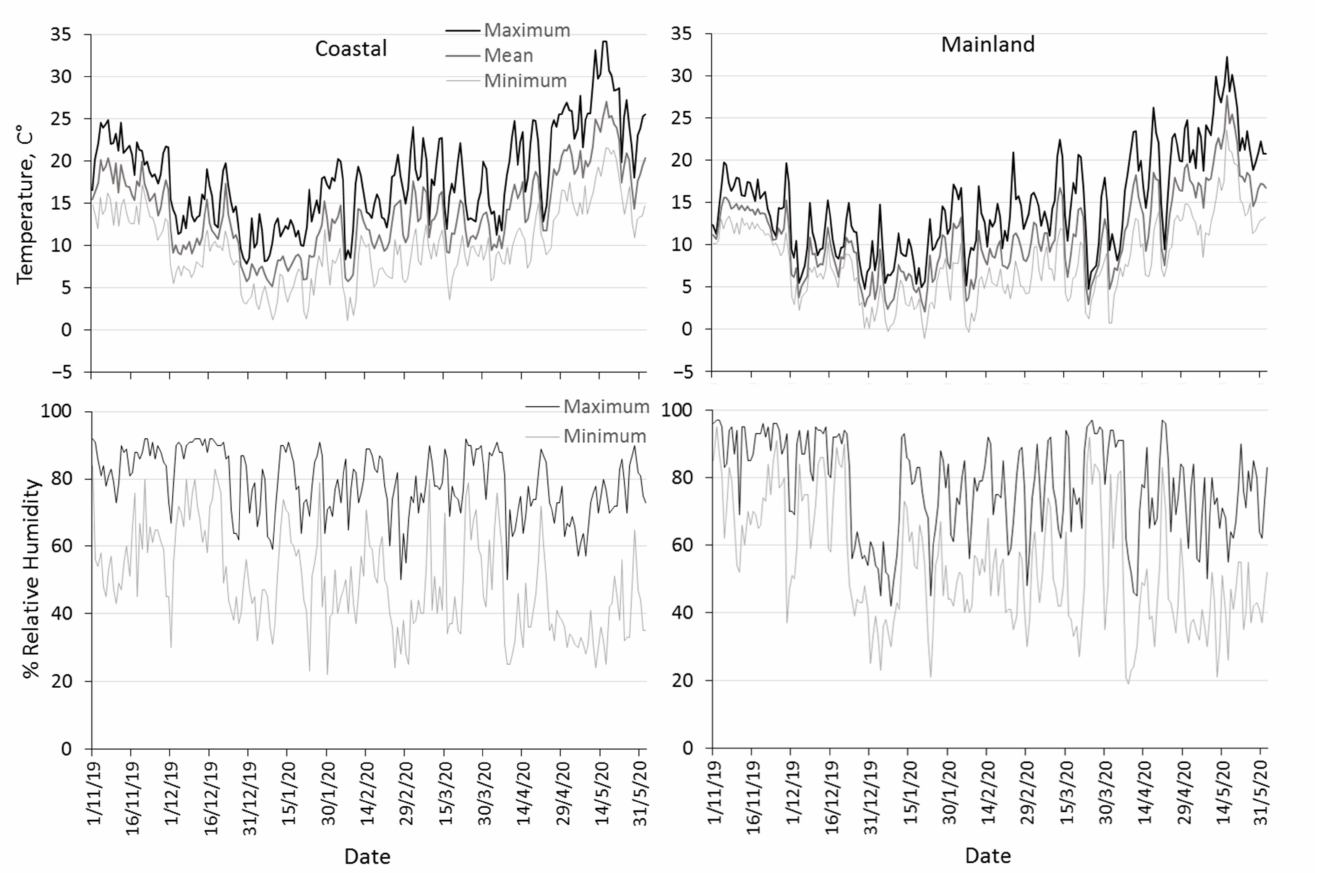
Figure 1. Seasonal patterns of maximum, mean and minimum daily temperature, maximum and minimum daily rel- ative humidity prevailing in the coastal area Volos ( left column ) and the mainland area Naousa ( right column )